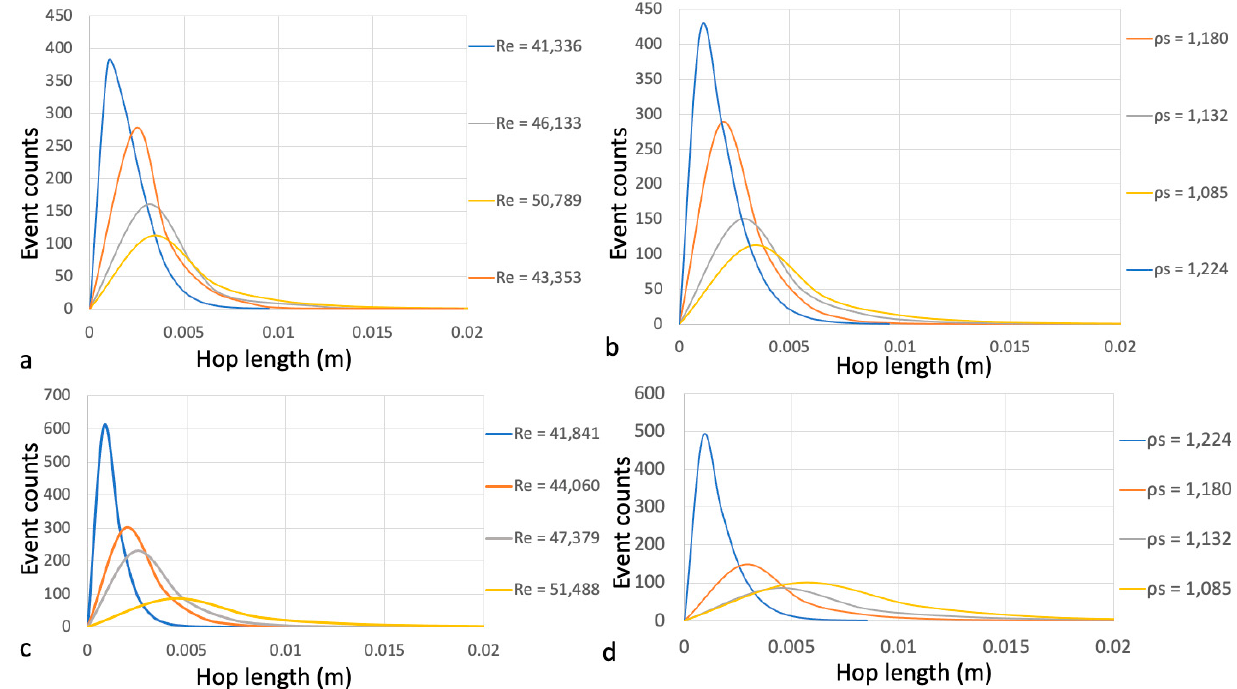
Figure 11. Hop length modelled by the Gamma distribution: ( a ) for different flow Reynolds numbers, bed surface A, and fixed instrumented particle density of 1132 kg/m 3 , ( b ) for different instrumented particle densities, bed surface A, and fixed Reynolds number of 50,789, ( c ) for different flow Reynolds numbers, bed surface B, and fixed instrumented particle density of 1132 kg/m 3 , and ( d ) for different instrumented particle densities, bed surface B, and fixed Reynolds number of 51,488.